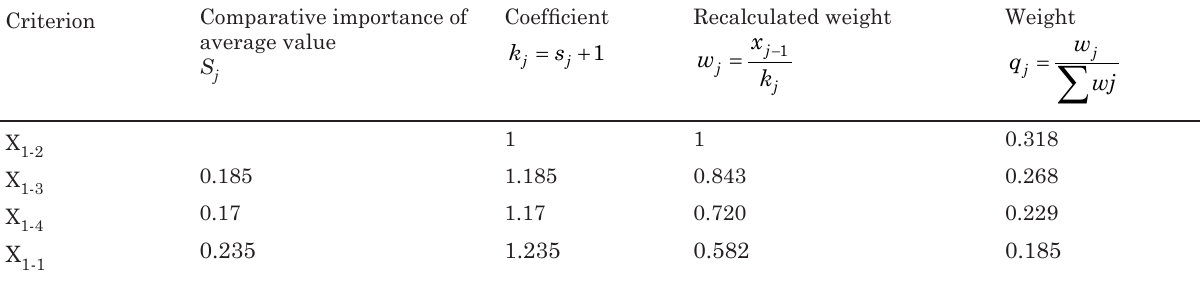
Table 5. Final results of SWARA method in weighting physical condition and potential criteria Criterion